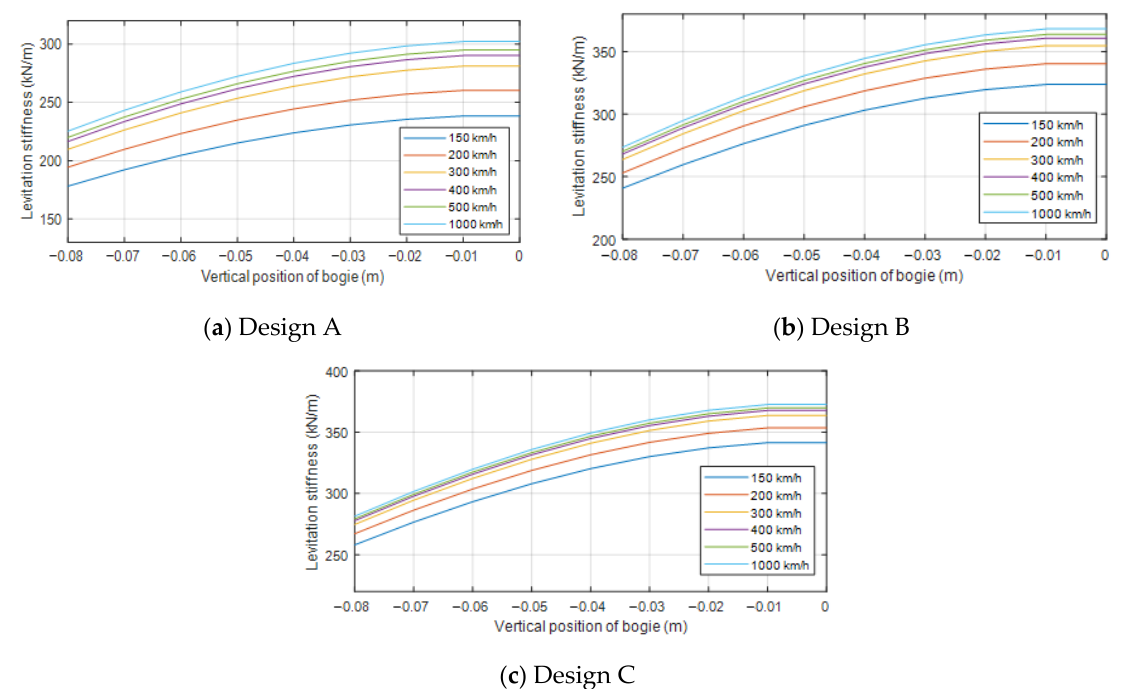
Figure 8. Relationship between levitation stiffness and vertical position (average).